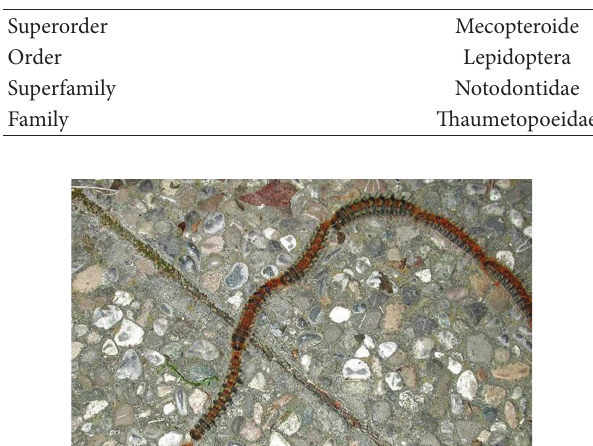
Table 1: Common urticarial Lepidoptera [15, 16] ∗ . Table 2: Thaumetopoea pityocampa Schiff.